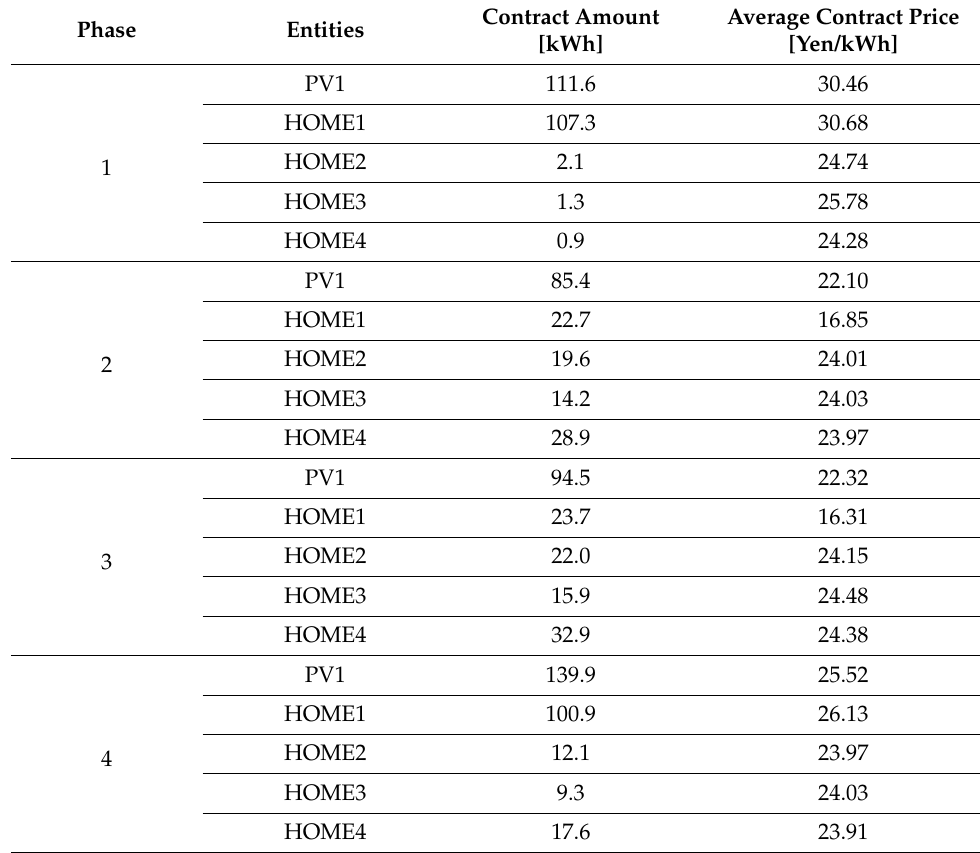
Table 4. Amount and price of electricity traded by each user per experimental phase.